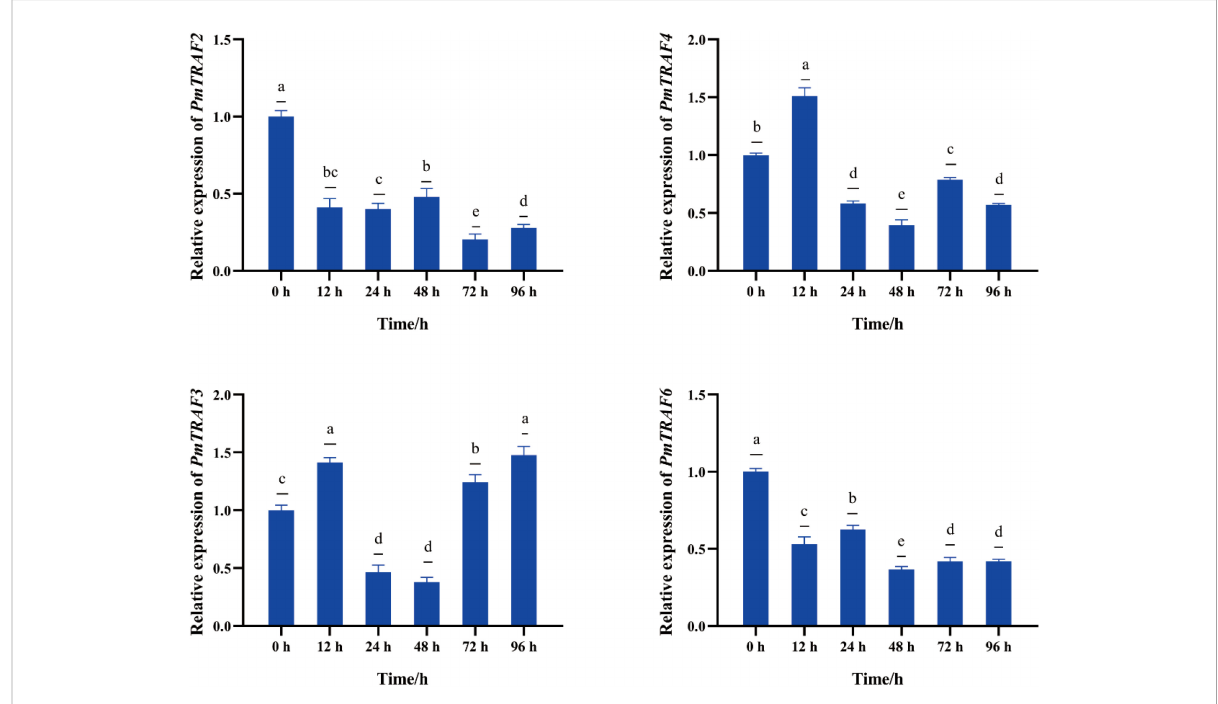
FIGURE 6 The mRNA expression of PmTRAFs in nuclear insertion surgery. Relative expression was expressed as the mean ± S.D. (n = 5). Different superscript letters indicate a signi fi cant difference in the groups ( p <